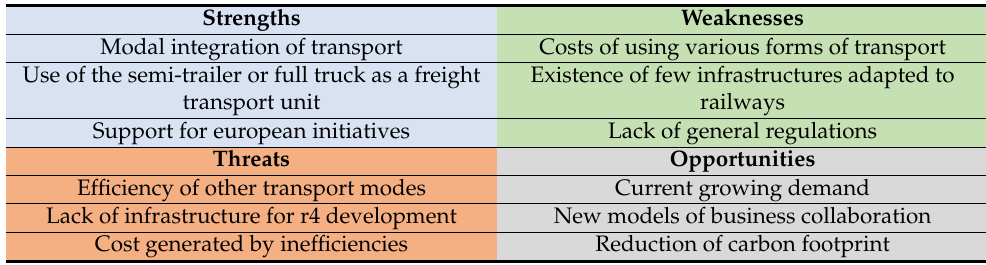
Table 1. SWOT Results. Source: Own